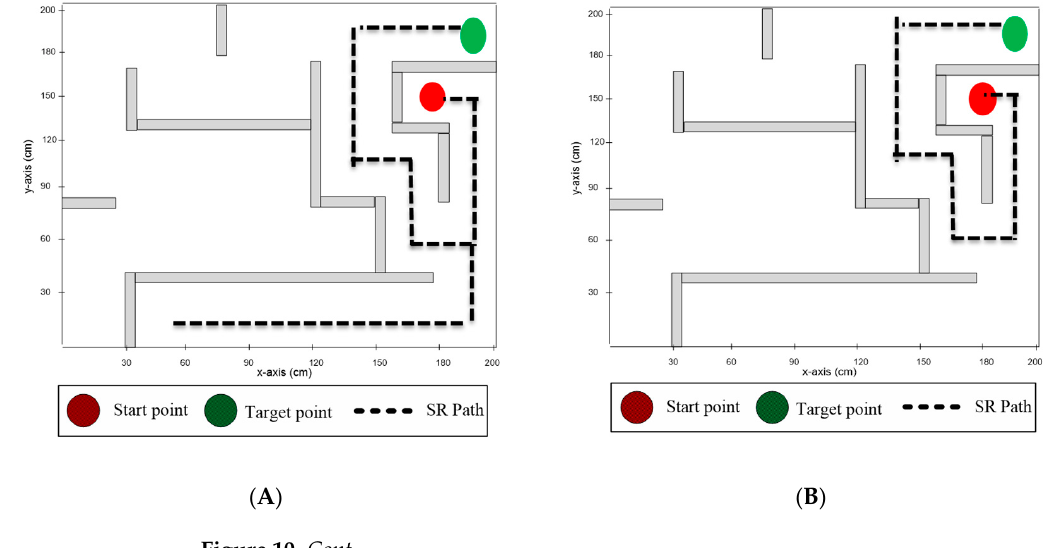
( D ) Figure 10. The route of the solver robot using 4 algorithms in testbed # 2. ( A ) Pledge algorithm; ( B ) right-hand algorithm; ( C ) left-hand algorithm; ( D ) MWFS. Table 7. Experimental results obtained from the second experiment testbed. No. Maze System Average Time Distance to Destination Total Distance Traveled # of Visited Paths